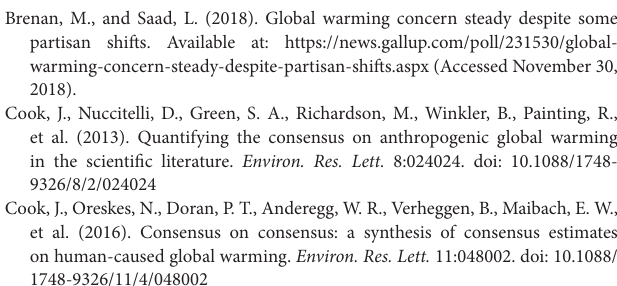
FIGURE S1 | A heatmap showing the average duration of dwell time on the temperature curve for independents ( N = 14) in the temperature condition. Participants whose ratings on the political orientation scale were 0 were grouped as independents. Warmer colors represent higher average duration of dwell time.